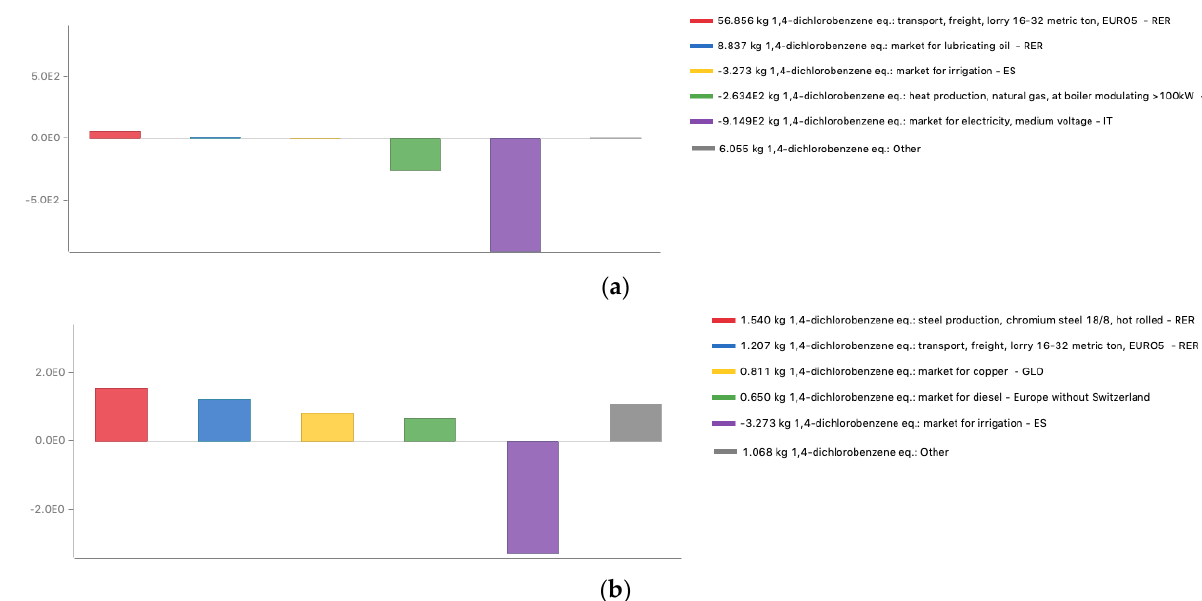
Figure 9. Human Toxicity: top 5 contributions impacting category results: ( a ) Cradle-to-grave analysis; ( b ) Downstream process.